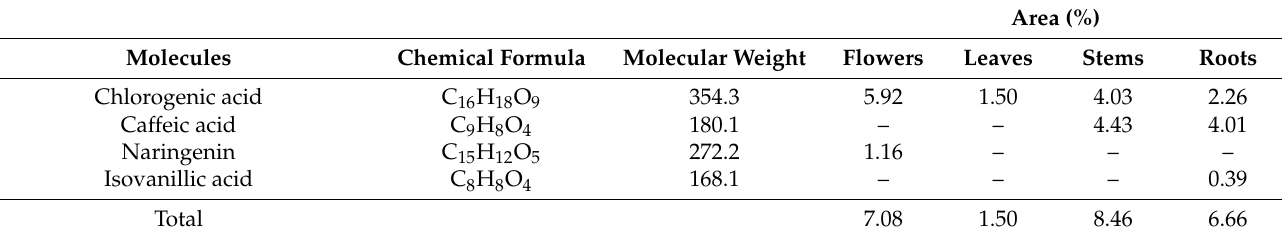
Table 8. Amino acids of derivatized methanolic extracts obtained by GC-MS.